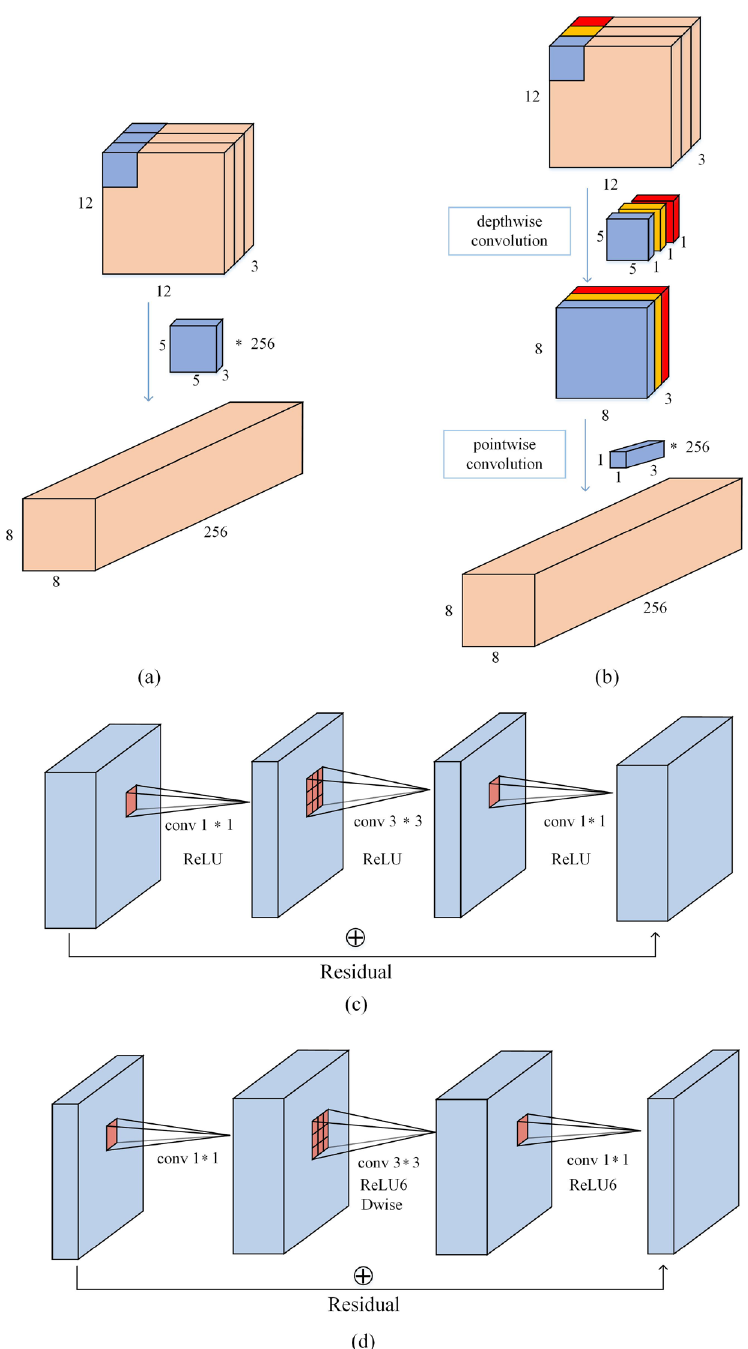
Figure 4. ( a ) Traditional convolution; ( b ) Depthwise separable convolution; ( c ) Residual block; ( d ) Inverted residuals and linear